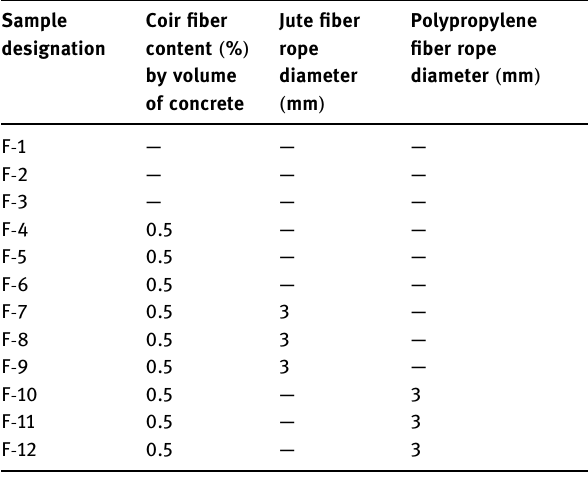
Table 4: Beam specimen details for fl exural